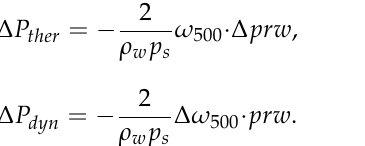
Therefore, uncertainty in the precipitation can be traced into uncertainty from different